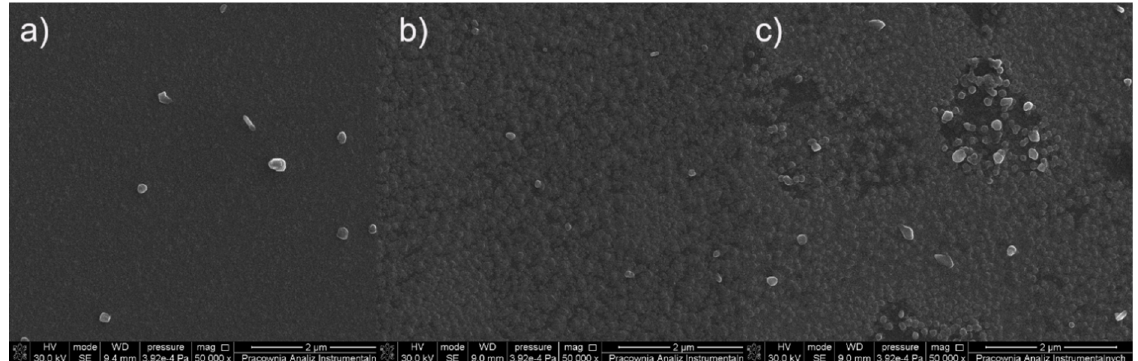
Figure 9. SEM pictures of deposits for the precursor [Cu 2 ( i PrNH 2 ) 2 (µ-O 2 CCF 3 ) 4 ] ( 7 ), Mag = 50,000×, (( a – c )-orderly with the increasing transport way), T V = 453 K, T D = 573 K, Si(111), Ar.